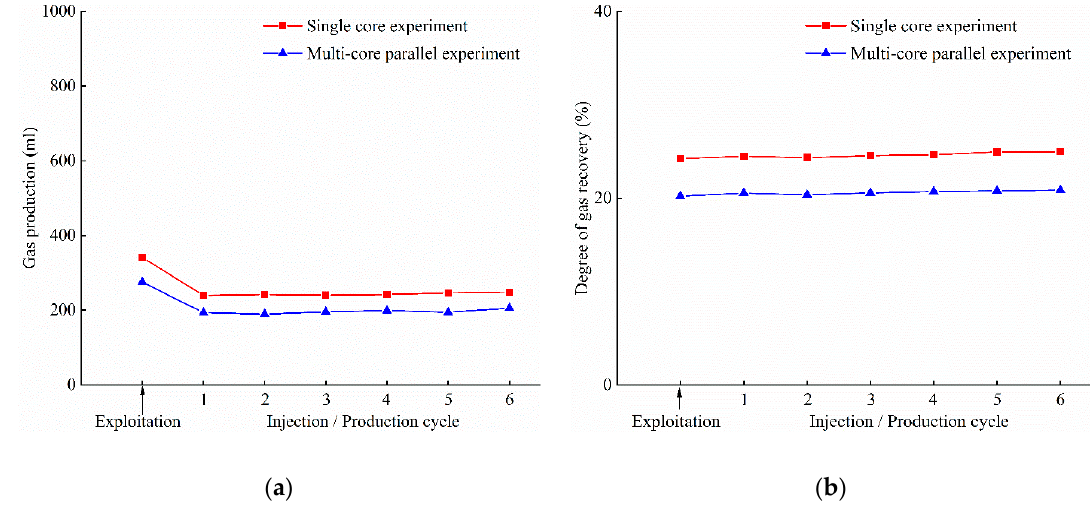
Figure 15. Variation curve of gas production ( a ) and degree of gas recovery ( b ) with reservoir heterogeneous in the gas-water transition zone. heterogeneous in the gas-water transition